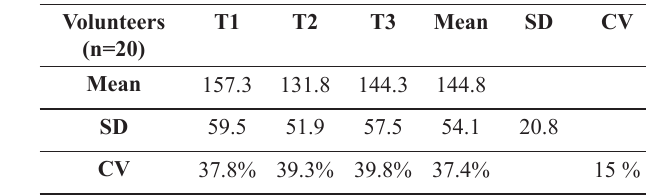
2. Mean time values (in seconds) obtained in the Biering-Soren- sen test in three trials (T1, T2 and T3).